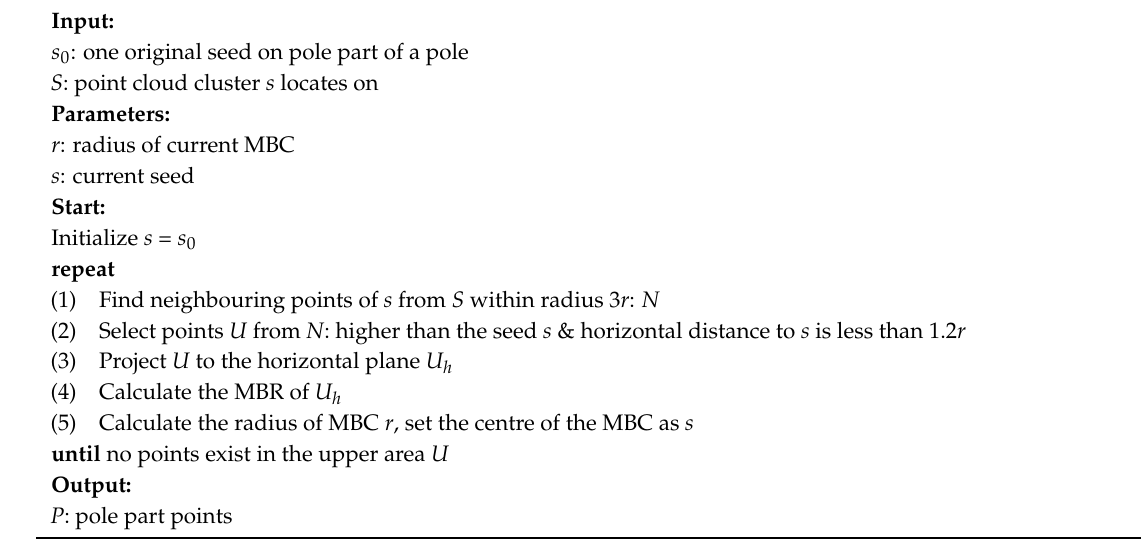
Figure 6. Road pole detection in two typical cluttered scenes: ( a ) The cluster of a cluttered scene with point coloured by height. ( b ) Detected pole part by vertical growing algorithm from ( a ). ( c ) One detected manmade structure by region growing based on roughness from ( a ). ( d ) United detection result of pole part and manmade structure from ( a ). ( e ) Another cluster of a cluttered scene with point coloured by height. ( f ) Detected pole parts by vertical growing algorithm from ( e ). ( g ) Two detected manmade structures by region growing based on roughness from ( e ). ( h ) United detection result of the pole part and manmade structure from ( e ). Algorithm 2 Vertical growing